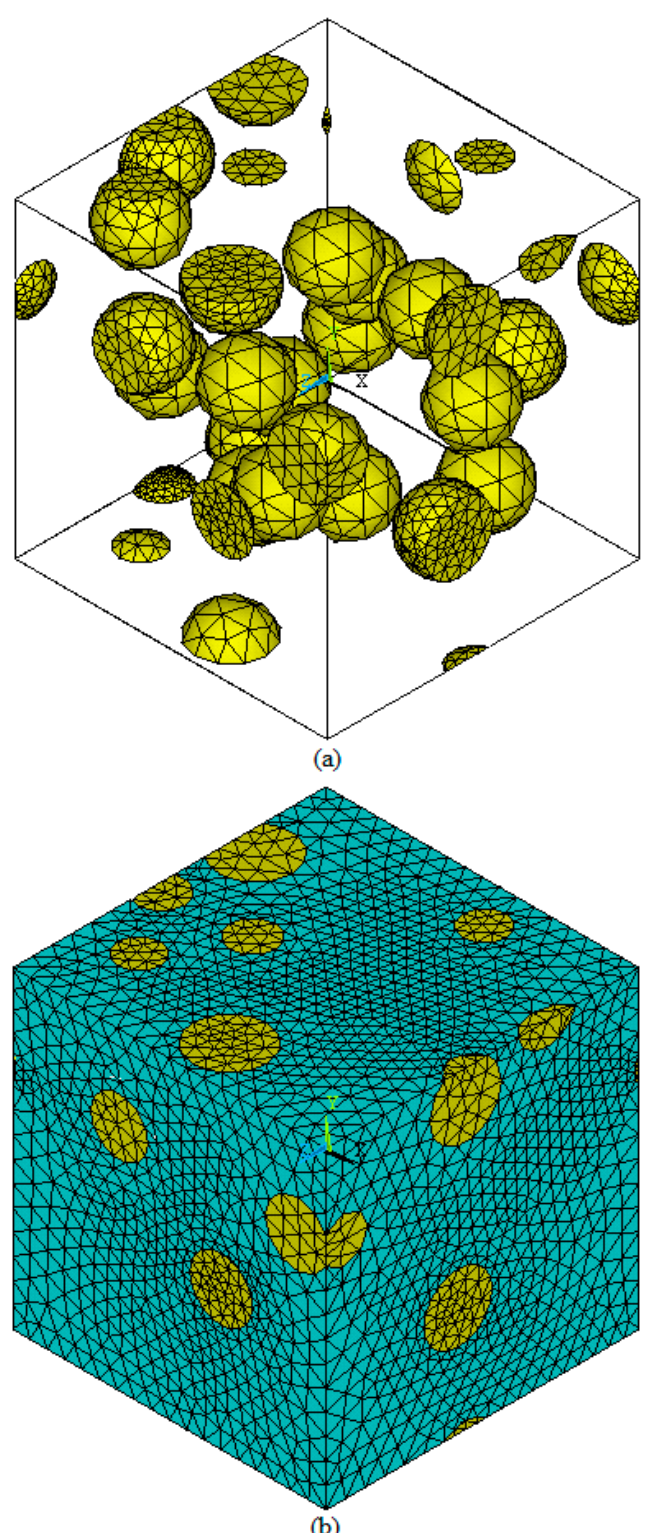
Figure 5. ( a ) Meshed particles only. ( b ) Meshed